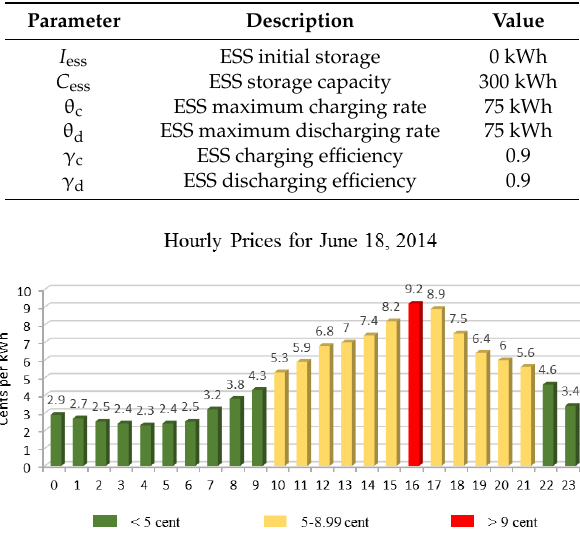
Table 5. Parameters for the Energy Storage System (ESS).